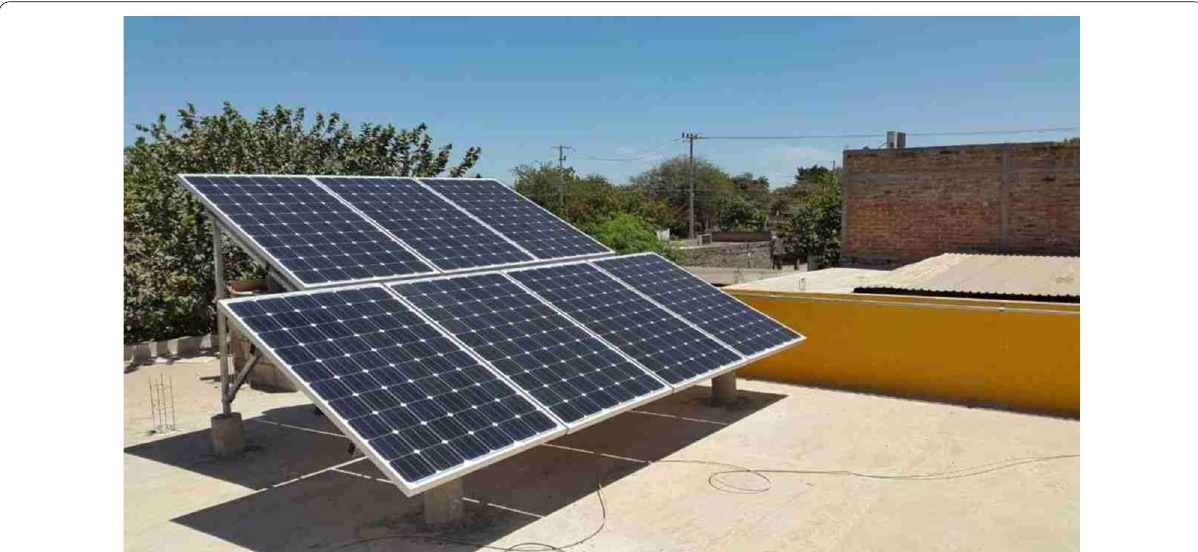
Fig. 20 Cooperative photovoltaic panels in Melpignano, Puglia, IT (from http://www.coopc omuni tamel pigna no.it)